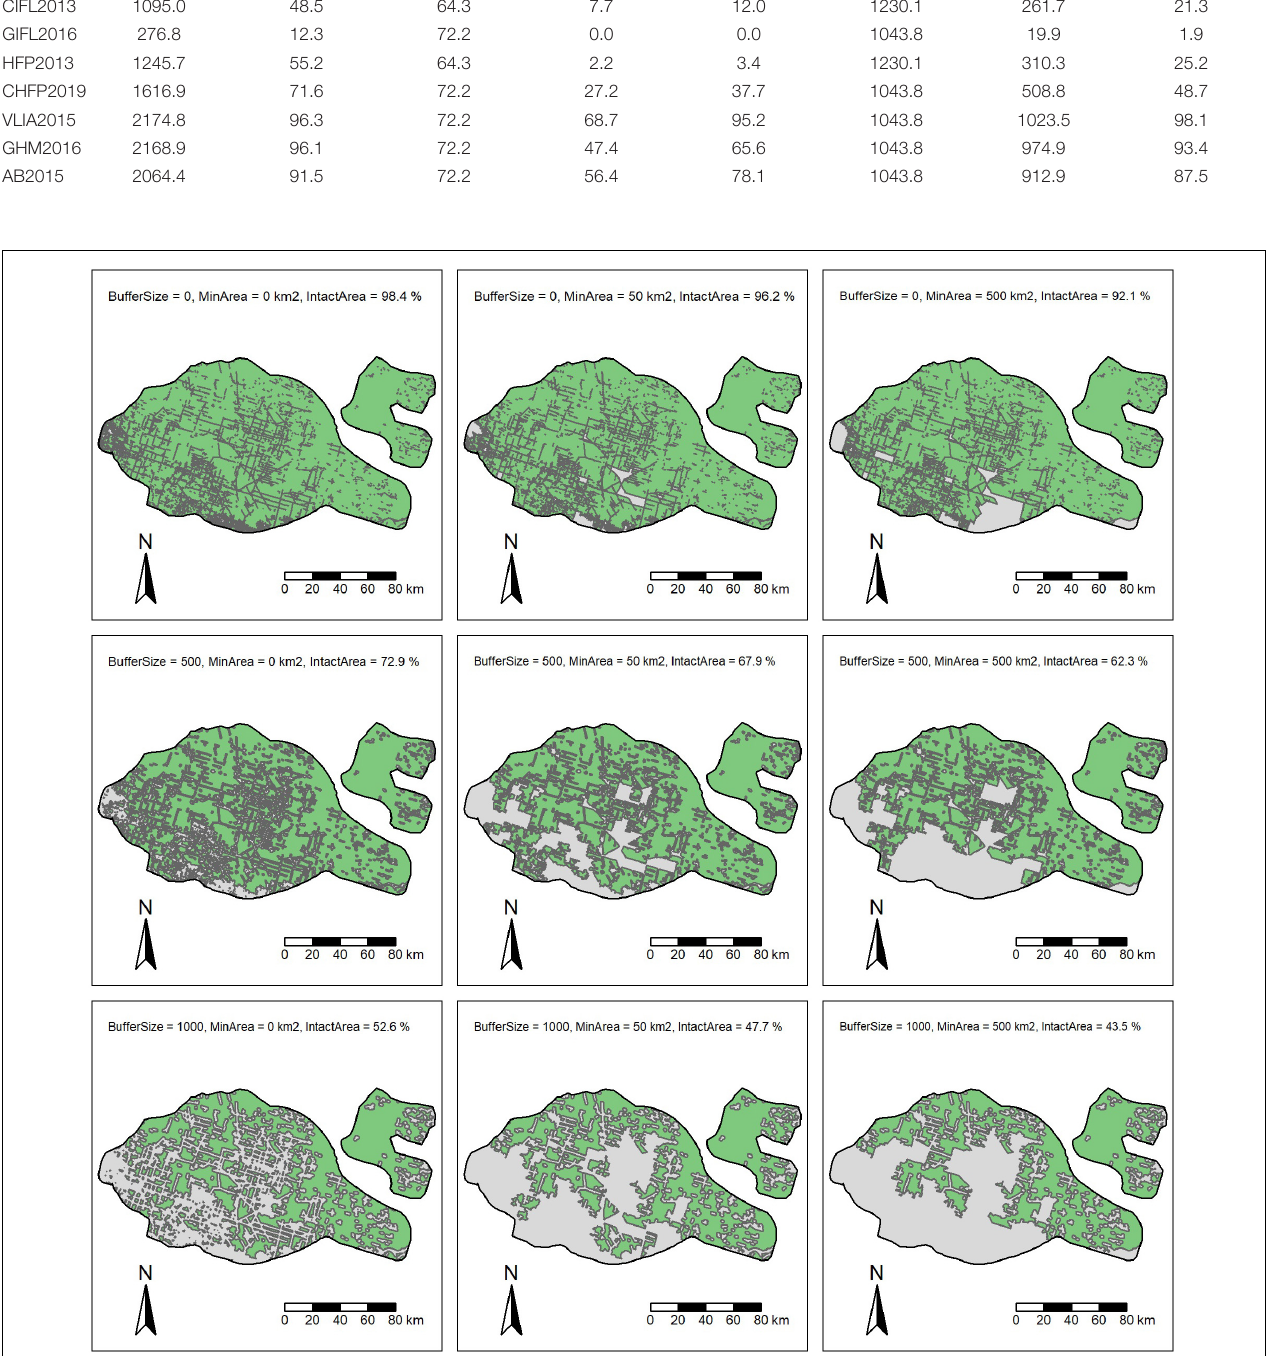
FIGURE 3 | Distribution of intact area identified as a function of buffer size around anthropogenic disturbances and minimum intact patch size.